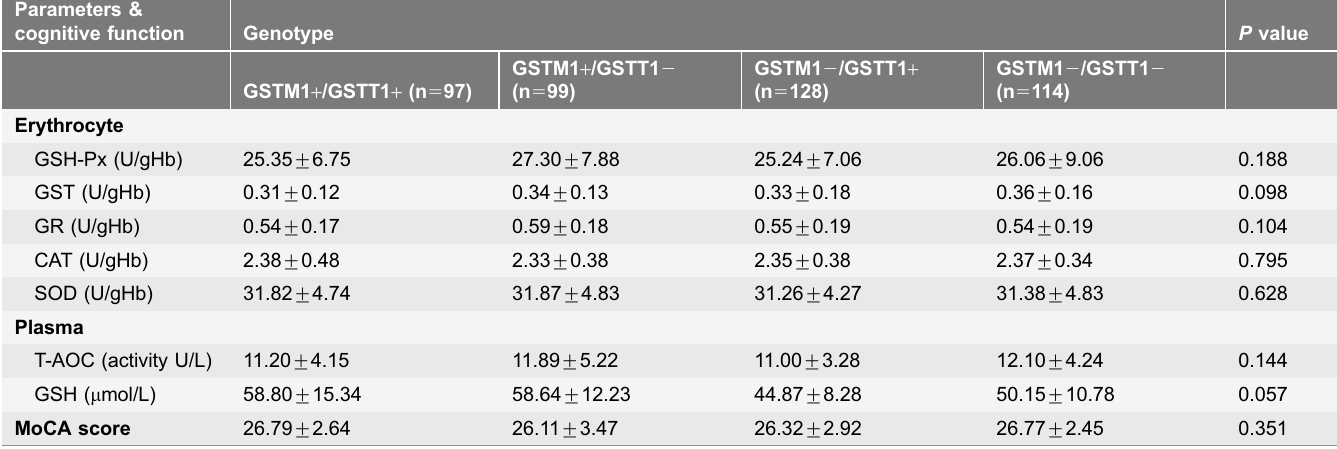
Table 5. Antioxidant parameters and cognitive function according to combined GST